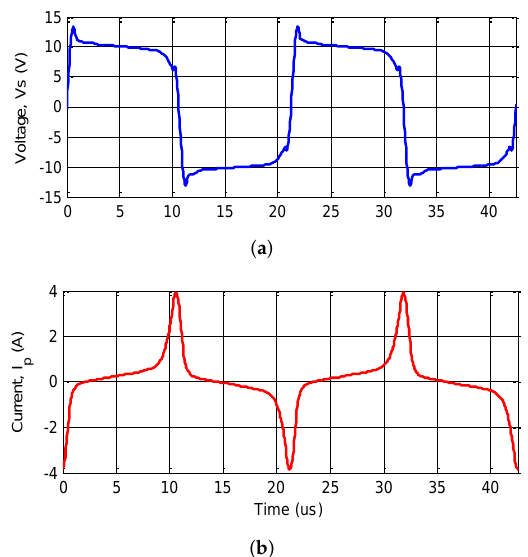
Figure 6. Experimental measurements. ( a ) Voltage applied to the toroid, and ( b ) current flowing through the main winding. Table 3. Estimated Jiles-Atherton parameters for N87 and 3C90 magnetic materials at 50 kHz.